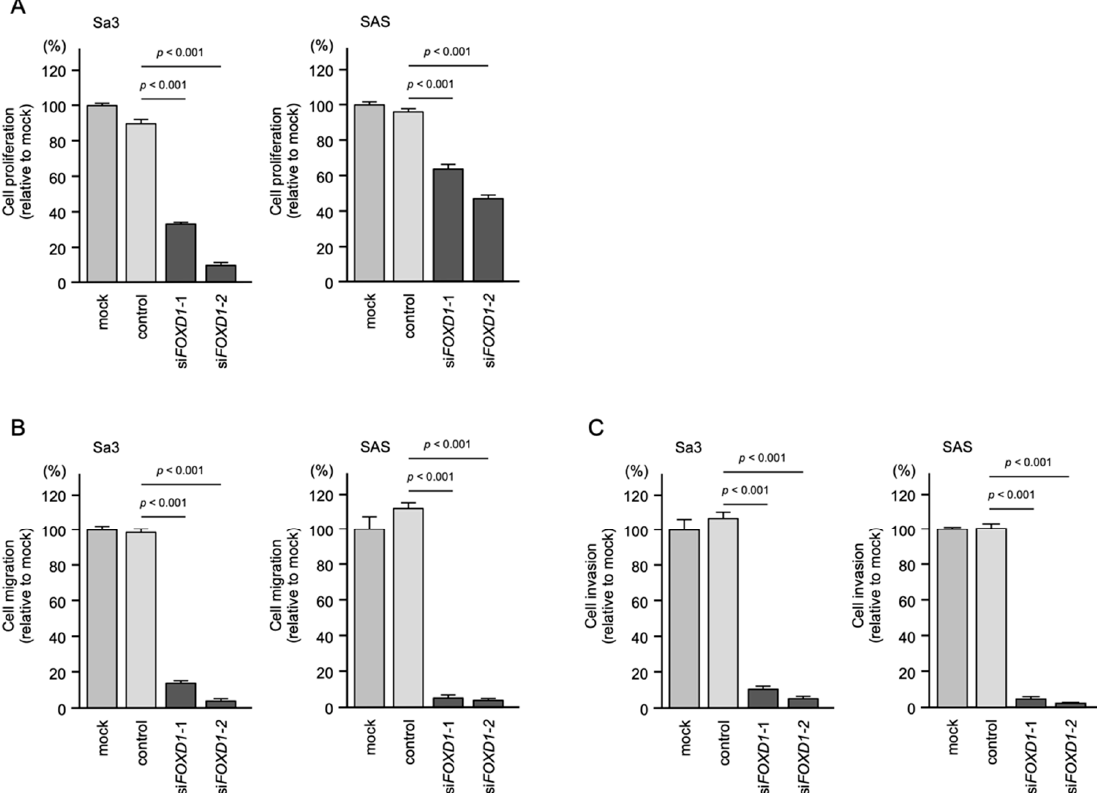
Figure 12. Functional assays of cell proliferation, migration, and invasion following transient transfection of siRNAs targeting FOXD1 in HNSCC cell lines (Sa3 and SAS cells). ( A ) Cell proliferation assessed by XTT assay 72 h after siRNA transfection. ( B ) Cell migration assessed using a membrane culture system 48 h after seeding miRNA-transfected cells into the chambers. ( C ) Cell invasion assessed by Matrigel invasion assays 48 h after seeding miRNA-transfected cells into chambers.